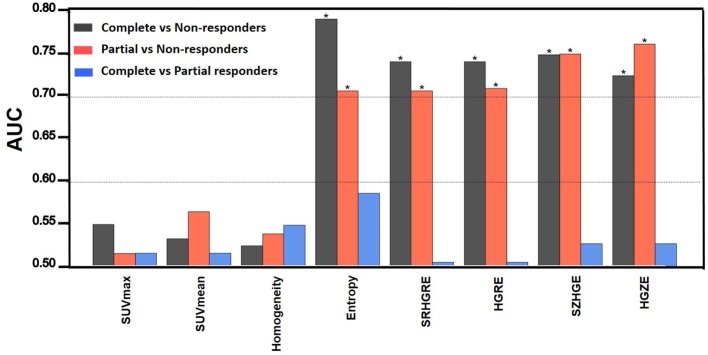
The area under the receiver operating curve (AUC). * indicates p < 0.05. HGRE, high-gray-run emphasis; HGZE, high-gray zone-run emphasis; SRHGRE, Short-run high-gray-run emphasis; SZHGE, short-zone high-gray-run emphasis.